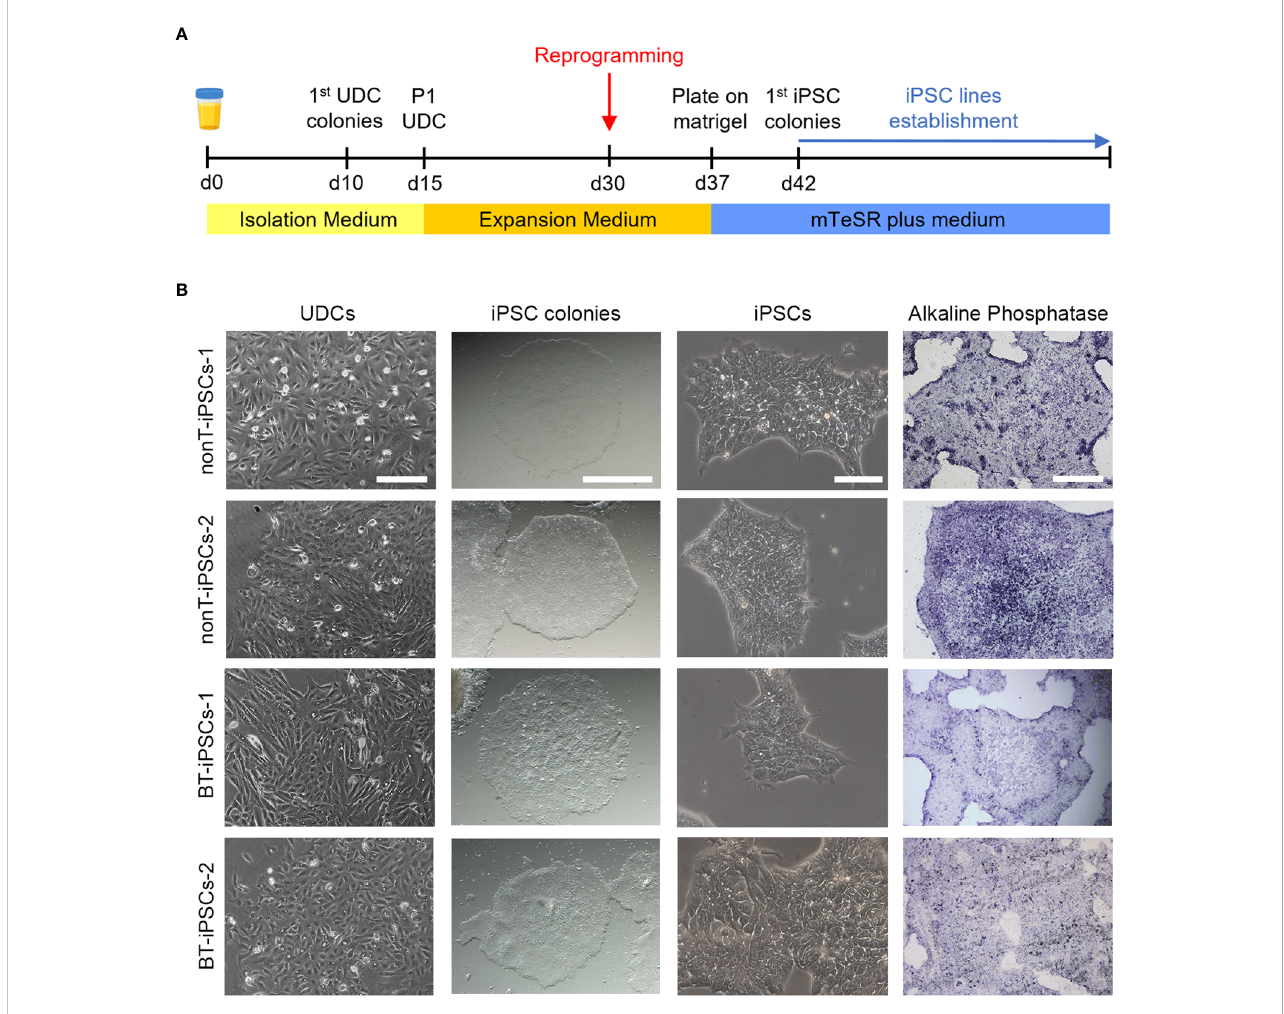
FIGURE 2 Isolation of UDCs and reprogramming process. (A) Schematic timeline of the process for isolation and expansion of UDCs and iPSC generation. (B) Microscope images showing the morphological aspect of cultured UDCs (scale bar 200 µm), iPSC colonies obtained after selective passaging post- reprogramming (scale bar 1 mm), iPSCs at higher magni fi cations (scale bar 100 µm) and alkaline phosphatase staining of iPSC colonies (scale bar 400